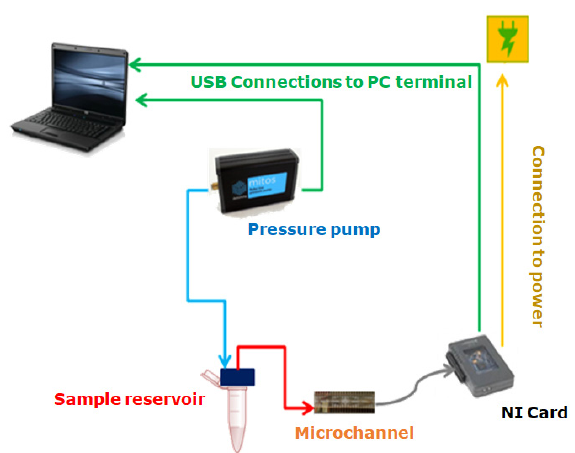
Figure 5. Experimental setup for laboratory use.